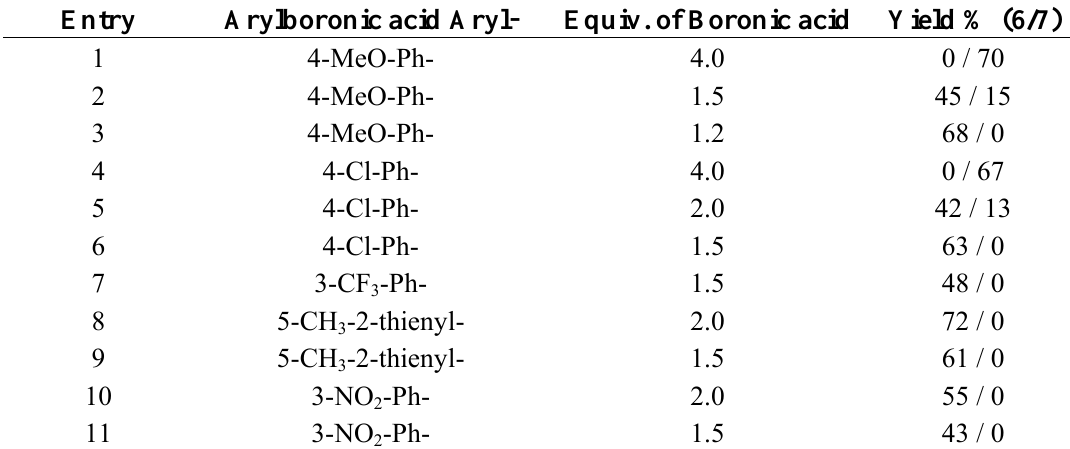
Table 1. Regioselective Suzuki-Miyaura coupling reaction.